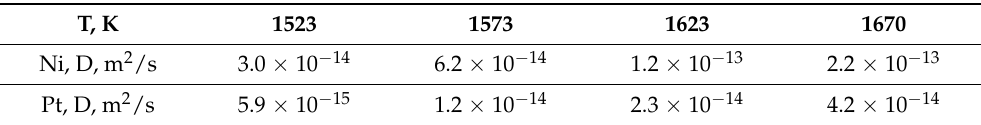
Table 1. Values of self-diffusion coefficients D for Ni and Pt in the coinciding temperature range 1523–1670